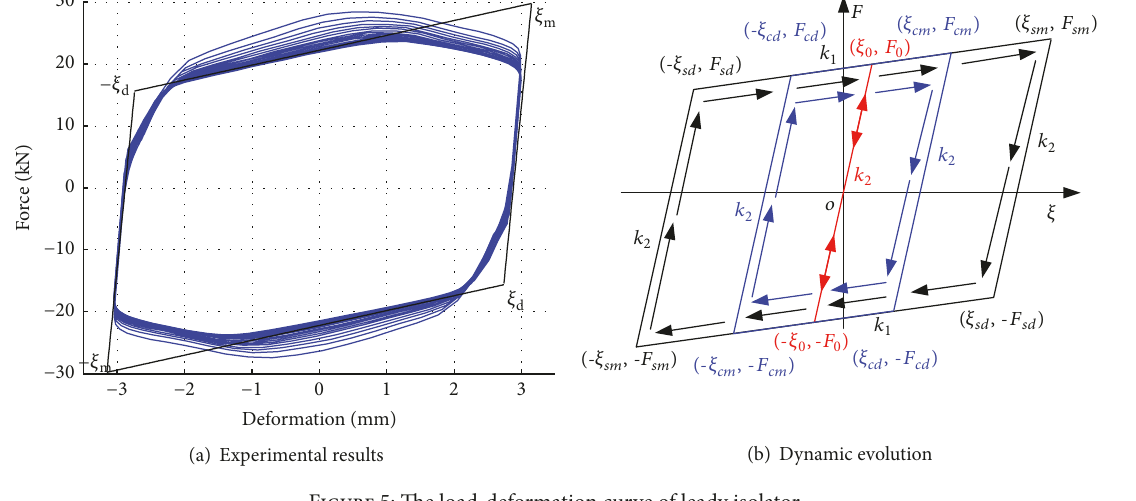
Figure 5: The load-deformation curve of leady